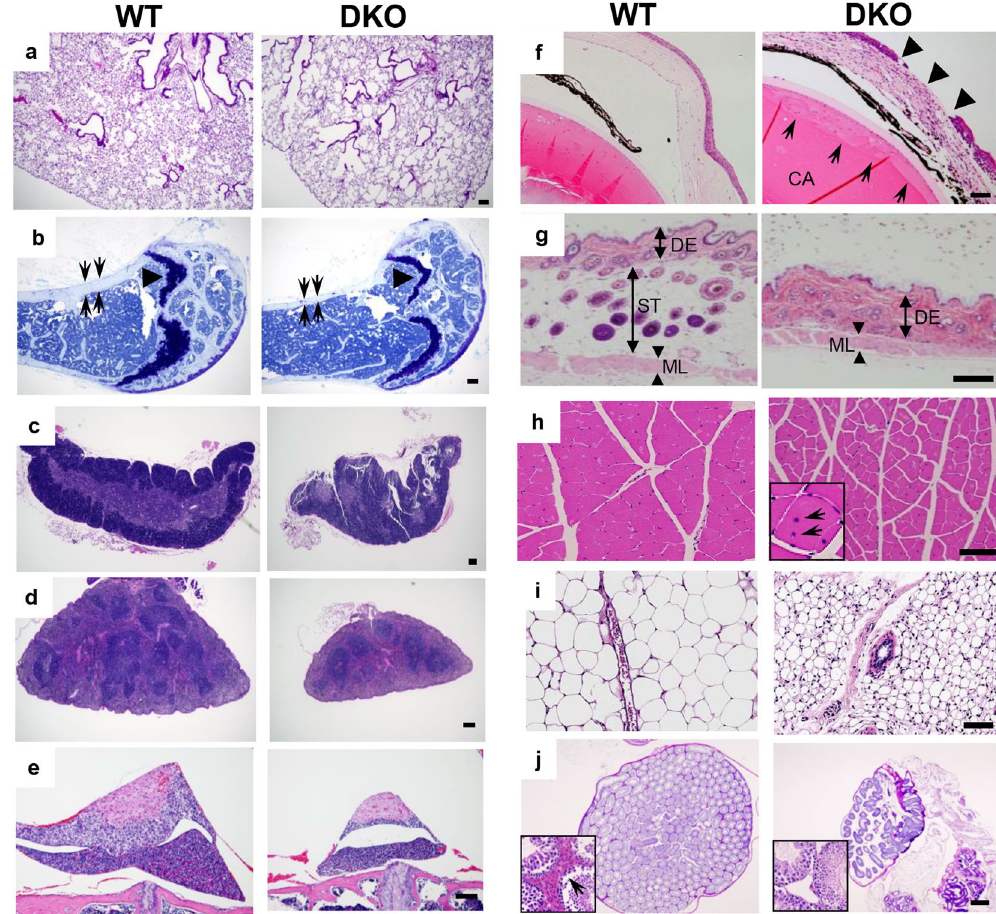
Figure 2. CD9/CD81 DKO mice exhibit multiple histological aging phenotypes. ( a – j ) Histological sections from lungs ( a ), femur ( b ), thymus ( c ), spleen ( d ), pituitary ( e ), eye ( f ), skin ( g ), muscle ( h ), adipose ( i ), and testis ( j ). ( a ) Emphysematous lungs in DKO mice. ( b ) Note that the cortex (arrow) and growth plate (arrowhead) were much thinner in DKO. ( c , d , e ) Atrophy in the thymus, spleen, and pituitary in DKO mice. ( f ) Keratitis (arrows) and cataracts (CA) were remarkable in DKO mice. ( g ) Less subcutaneous fat and fewer hair follicles were observed in DKO mice. DE: dermis, ST: subcutaneous tissue, ML: muscle layer. ( h ) DKO mice exhibited diffusely atrophic myofibers, along with the central nuclei (arrows, inset). ( j ) Testis in DKO mice were more atrophic, and the numbers of both Sertoli cells and Leydig cells (inset) were severely diminished. All sections were stained with hematoxylin-eosin (HE), except testis ( j ), which was stained with periodic acid-Schiff (PAS), and femur ( b ), which was stained with toluidine blue. Data are representative of three independent studies with similar results. Scale bar, 0.5 mm for ( g ) and 100 μ m for ( a – f ) and ( h – j